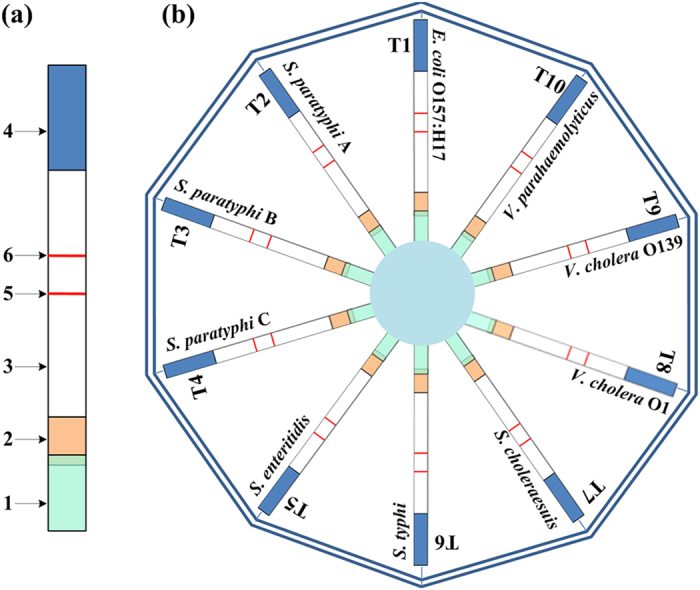
Schematic description of the UPT-LF strip and TC-UPT-LF disc.(a) The strip is composed of a sample pad (1), a conjugate pad (2), a nitrocellulose membrane (3), and an absorbent paper (4). During preparation, the conjugate pad was fixed with the UCP–antibody complex, and the membrane was coated with a test lane (5) and a control lane (6). (b) The TC-UPT-LF disc holds 10 detection channels (T1 to T10), which contain the appropriate UPT-LF strips for the target bacteria.